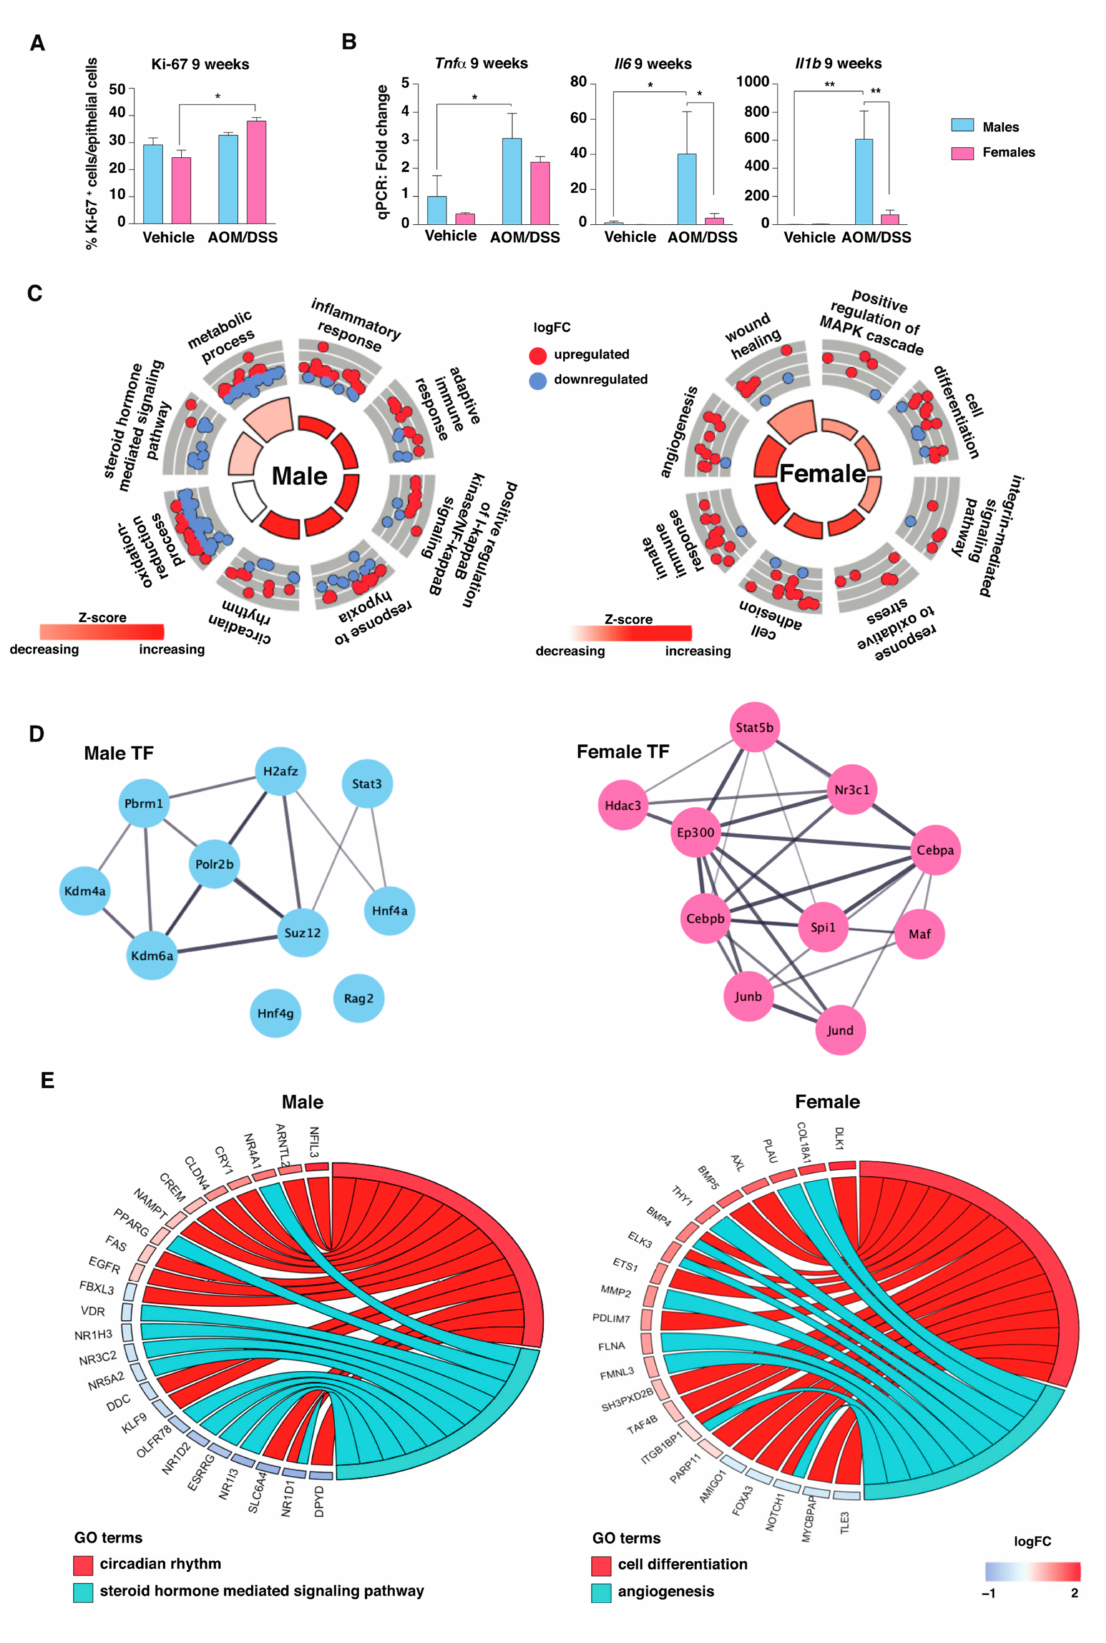
Figure 2. The sex-dependent response to 9 weeks AOM/DSS treatment. Comparison of ( A ) Ki-67 protein levels (immunohistochemical analysis) and ( B ) expression of the pro-inflammatory